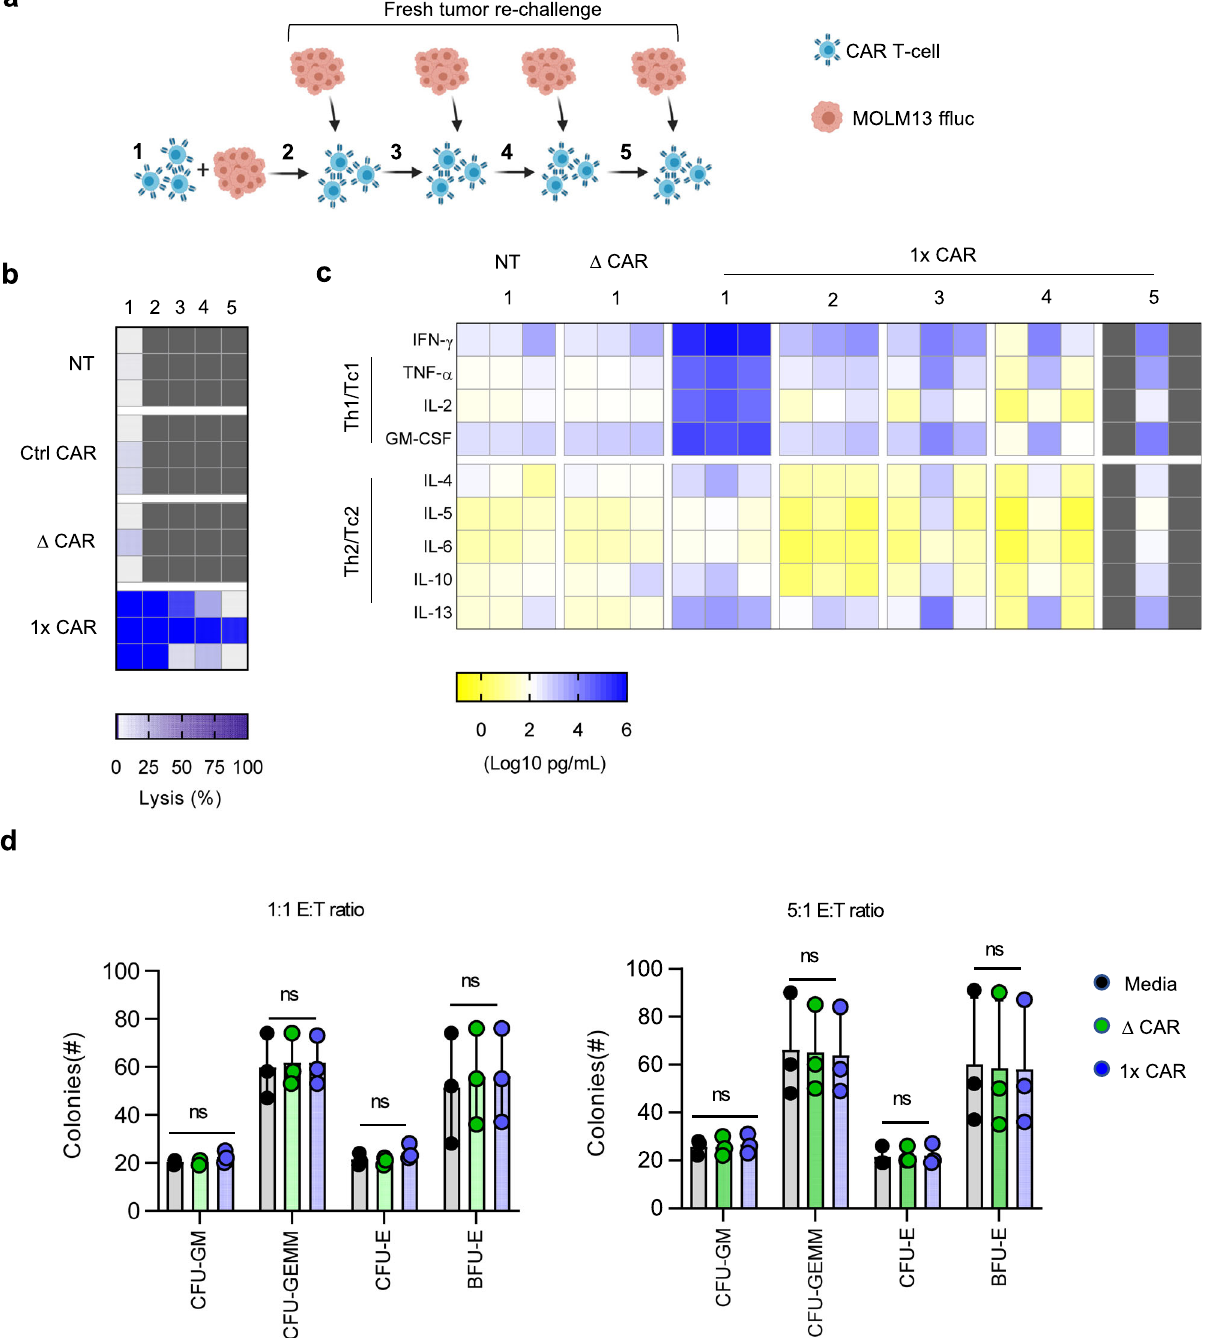
Fig. 4 GRP78-CAR T cells sequentially kill tumor cells and secrete cytokines and do not target normal HPCs. a Schematic for serial stimulation assay using MOLM13 f fl uc. cells. b , c Serial stimulation assay using effector T cells (GRP78.1x-CAR, control CAR, Δ CAR or NT T cells) and MOLM13 cells. Fresh MOLM13 cells were added every 72 h ( N = 3). b Luciferase-based cytotoxicity assay ( N = 3). c Multiplex analysis of cytokine production by GRP78-CAR T cells or control effector T cells (NT T cells or Δ CAR) against MOLM13 cells at a 1:1 E:T ratio. Supernatant for ELISA was collected 24 – 72 h. after stimulation ( N = 3, T -test, p < 0.001). d CFU assay: Effector T cells were incubated with healthy adult HPCs for 4 h at E:T ratios of 1:1 and 5:1, plated on semisolid media, and BFU-E (burst forming unit — erythroid) and CFU colonies (colony-forming unit — erythroid: CFU-E, colony-forming unit — granulocyte, erythroid, macrophage, megakaryocyte: CFU-GEMM), were enumerated after 12 – 14 days ( N = 3, technical replicates; one-way ANOVA and T -test for pairwise comparison; * p = 0.0109; ns; not signi fi cant). The data in ( d ) are presented as mean values± SD. Source data are provided as a Source data fi